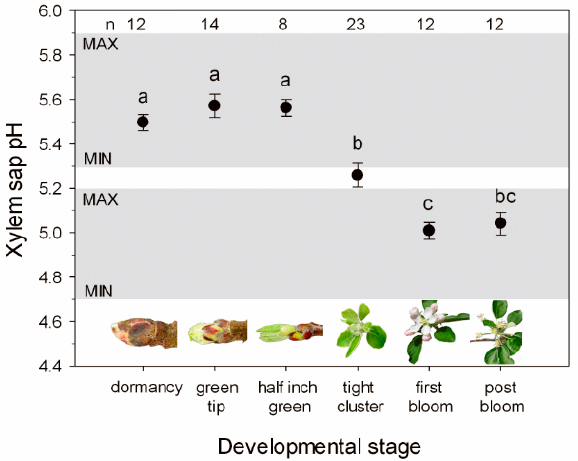
Figure 1. Seasonal change of pHx of twigs of M. domestica as related to the developmental stage of buds during flushing in spring. The grey boxes indicate the minimum and maximum for the respective season. Data (mean values ± SE, replicate numbers are given in the figure) are from December